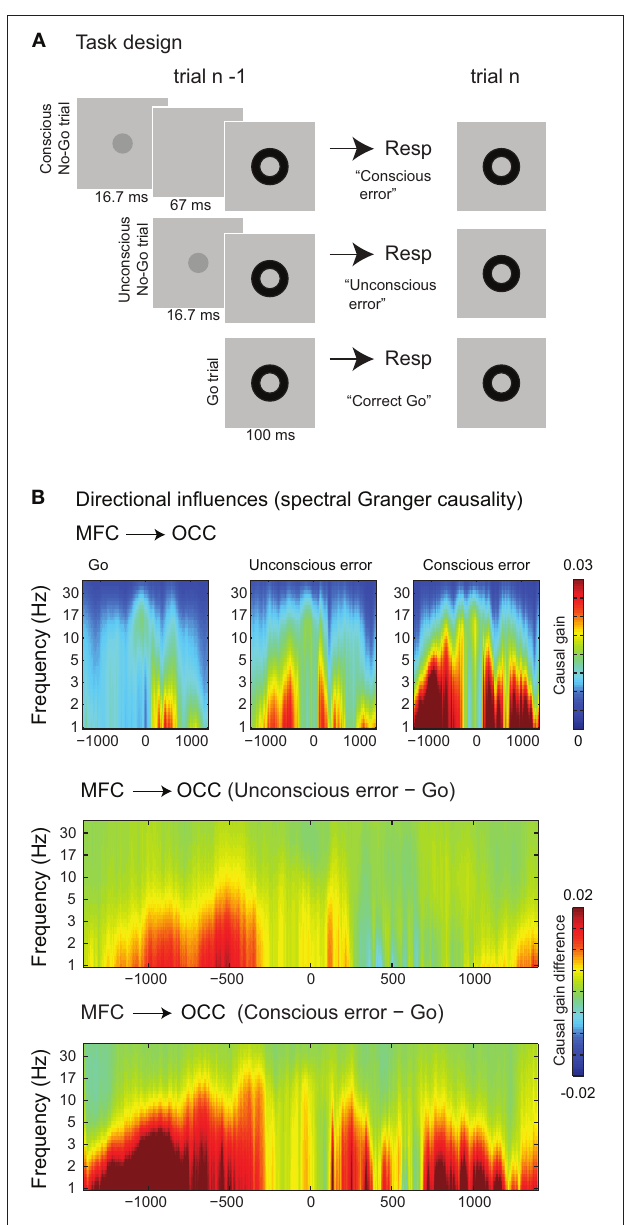
FIGURE 3 | (A) Task-set-up. (B) Response errors committed to trials containing a conscious No-Go signal and unconscious No-Go signal elicit long-lasting top-down influences from medial frontal (MFC) to occipital (OCC) regions (electrodes) in a broad frequency band ( ∼ 1–12Hz), leading up to the next trial. Effects for each of the three conditions separately (upper panel) and the difference plots (lower panel) are shown. Time 0 is the presentation of the Go-signal (black annulus). Plots are separated by the significance of the event on the previous trial (correct Go response, conscious error, or unconscious error). Adapted with permission from Cohen et al.